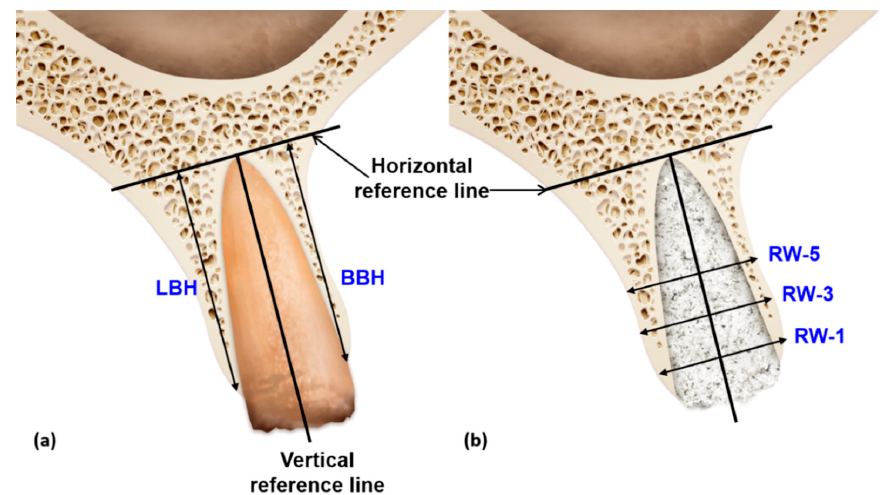
Figure 5. Schematic drawings of radiographic landmarks for measurement of the height and width of the alveolar ridge on CBCT images. The vertical reference line passed through the middle of the alveolar socket from the apex, and the horizontal reference line was drawn perpendicular to the vertical line. ( a ) The buccal and lingual bone heights were measured based on these reference lines relative to the marginal crest and root apex. ( b ) The horizontal ridge width was recorded at 1, 3, and 5 mm from the highest marginal crest.